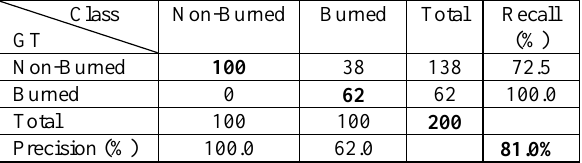
Table 3 . Confusion Matrix of ground truth (GT) and classification (Class) for the use case example in Indonesia using the local model. The bottom right cell displays the overall accuracy. The F 1 -score for non-burned is 84.7% and for burned 76.5%. Figure 2 . Example of false positive predictions in land cover classes like mangroves (top), urban (middle) and bare soil (bottom) in Indonesia (RGB composition: